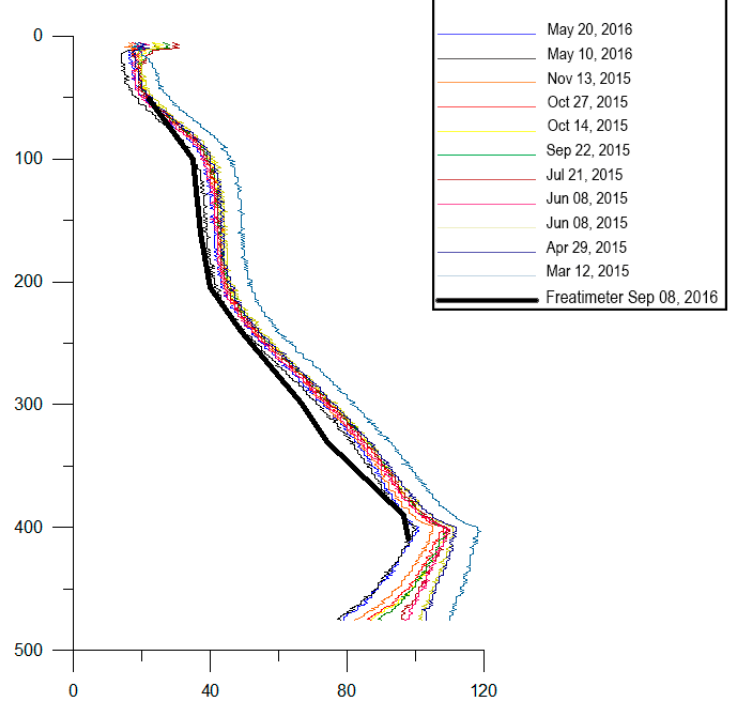
Figure 7. Temperature depth at different times along the CFDDP pilot hole.